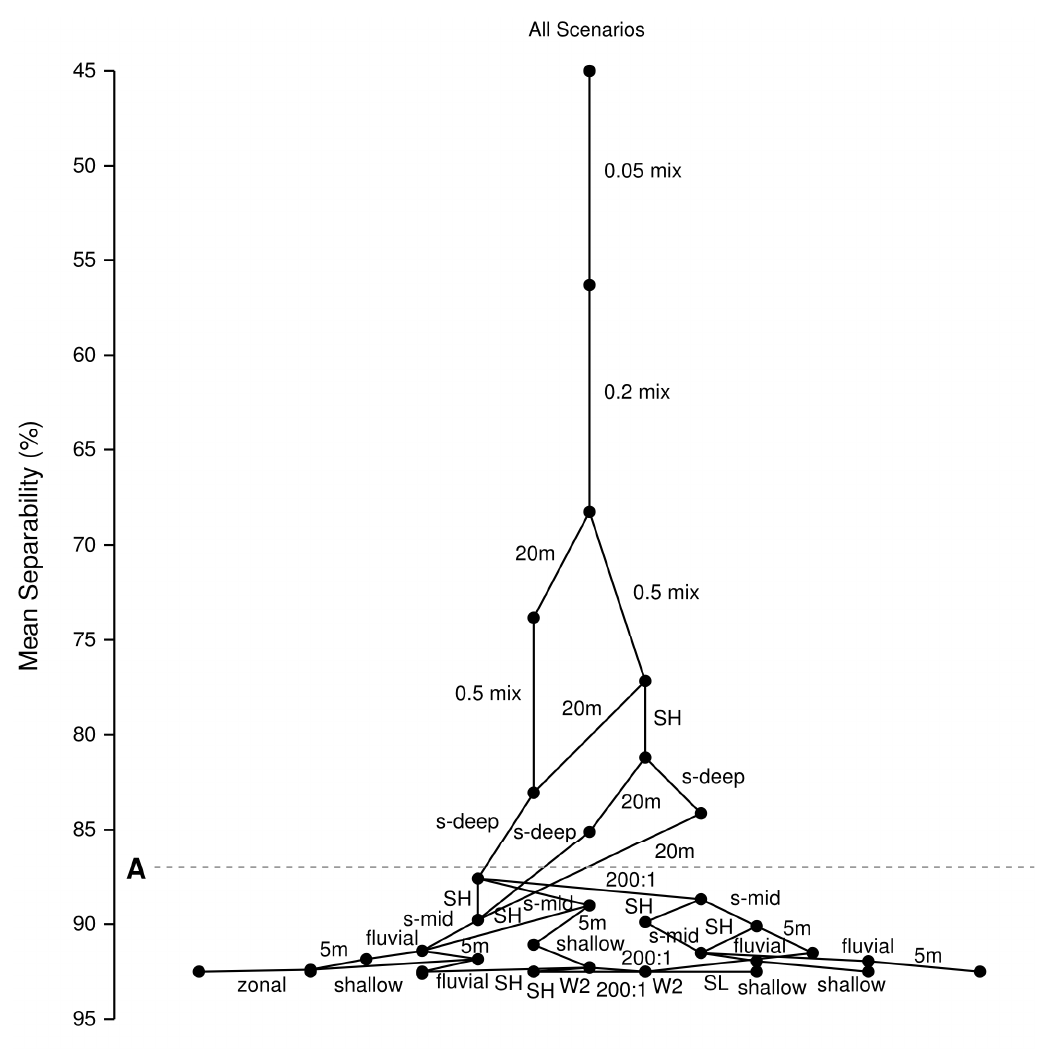
Figure 12. Hierarchical factor diagram for separability of Dead Coral from Live Coral. See caption of Figure 11 for full